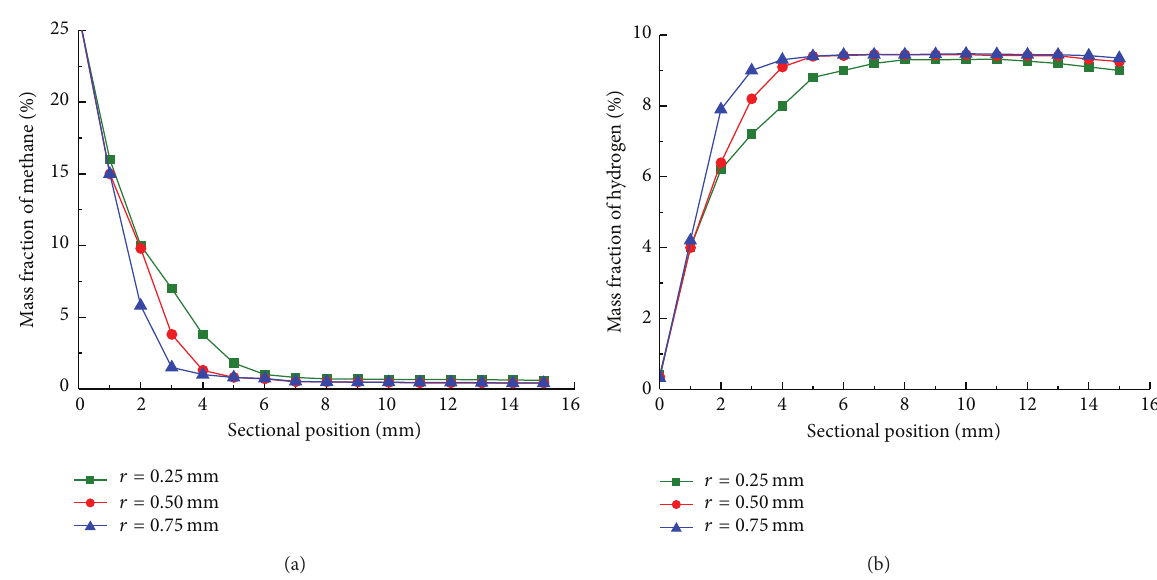
Figure 5: Mass fraction of (a) methane and (b) hydrogen along sectional position with cylinder radius of 0.25 mm ( ◼ ), 0.50 mm ( e ), and 0.75 mm ( 󳵳 ) in steady state.